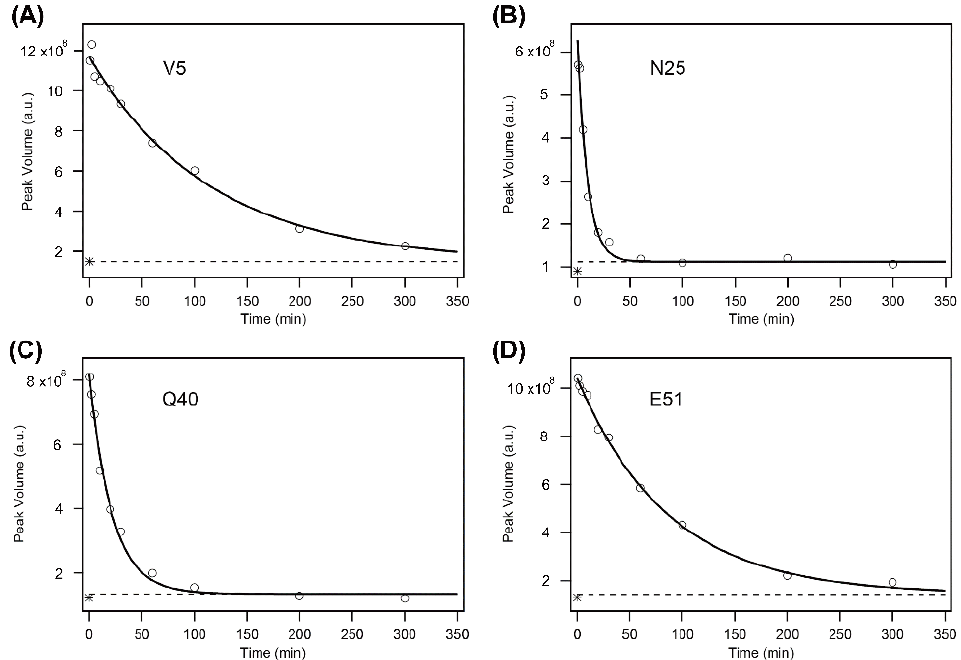
Figure 3. The H/D-exchange curves for Val5 (V5) ( A ), Asn25 (N25) ( B ), Gln40 (Q40) ( C ), and Glu51 (E51) ( D ) of human ubiquitin in 6 M GdmCl at pH* 3.3 and 15 °C. The solid lines are the theoretical curves best fitted to a single-exponential function (Equation (4)). A broken line in each panel indicates the theoretically estimated peak volume after the complete exchange (i.e., Y ( ∞ ) in Equation (4)), and an asterisk “*” in each panel, located between (1–2) × 10 8 of the peak volume, indicates the experimentally observed value after heating the sample at 50 °C for 30 min. Because the reaction mixtures contained 10% H 2 O, the final peak volumes did not reach zero. The k obs values for the four residues are: ( A ) (8.7 ± 0.8) × 10 −3 min −1 ; ( B ) (10.5 ± 1.2) × 10 −2 min −1 ; ( C ) (4.6 ± 0.4) × 10 −2 min −1 ; ( D ) (1.2 ± 0.1) × 10 −2 min −1 . The first and last time points are at 0.62 and 300.09 min, respectively, for all panels. Adapted with permission from Ref. [136]. Copyright 2020 Biophysical Society.